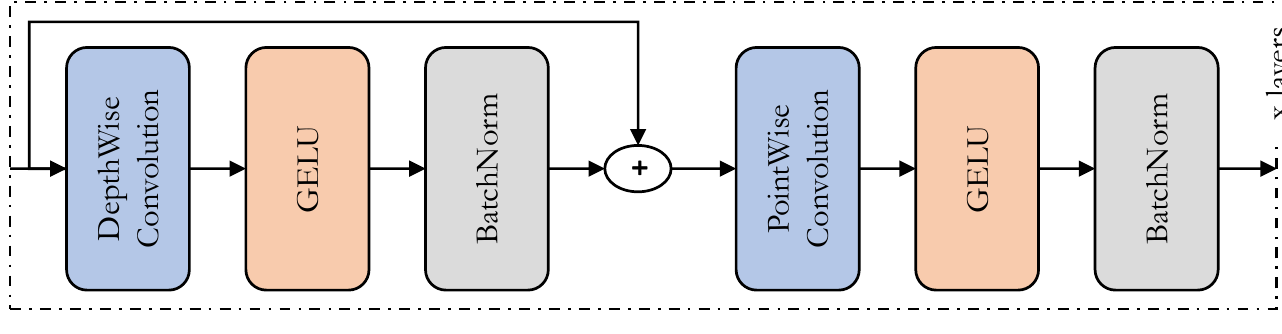
Figure 2. The architecture of the